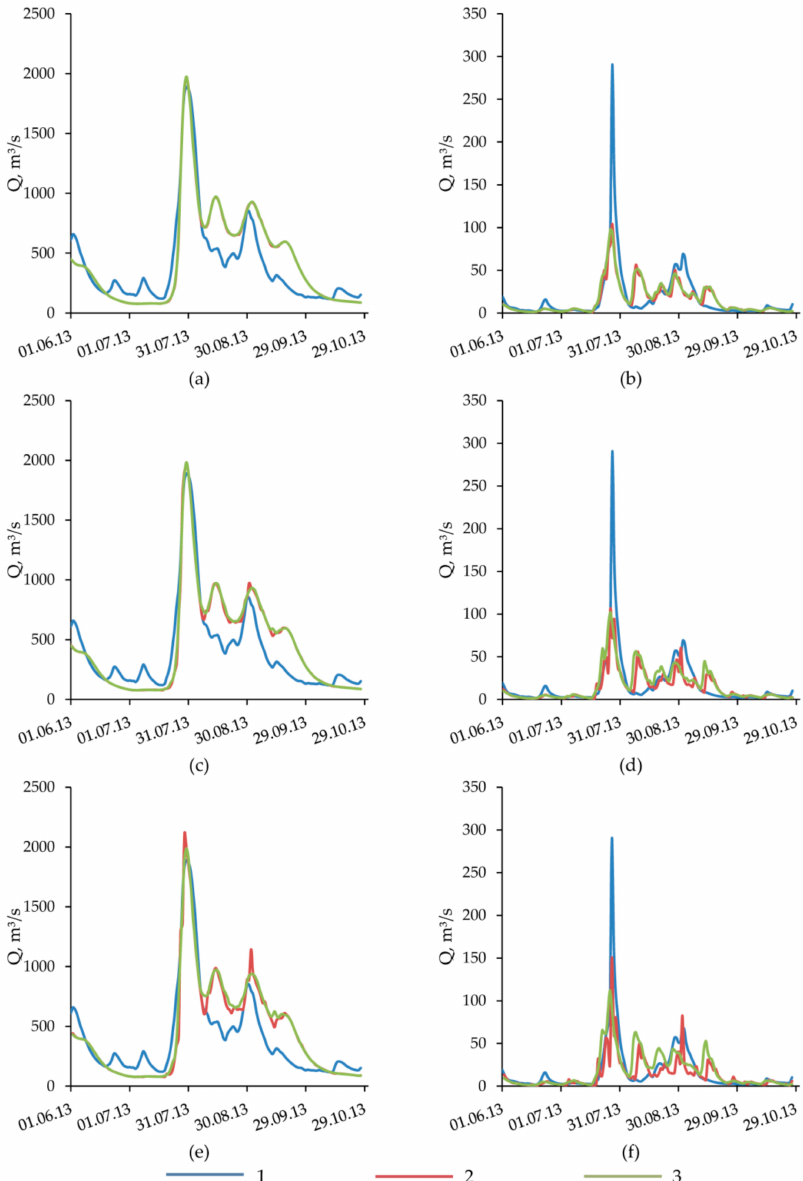
Figure 5. Examples of observed (1) and forecasted (2—with precipitation gradations, 3—with WRF data) runoff hydrographs of 2013 year in gaging stations Ussuri-Kirovskiy ( a , c , e ) and Krylovka- Krylovka ( b , d , f ) with lead time at 1, 2 and 3 days,